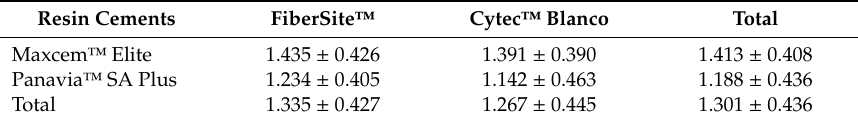
Table 2. Push-out bond strength (MPa, means ± standard deviations) of each group.